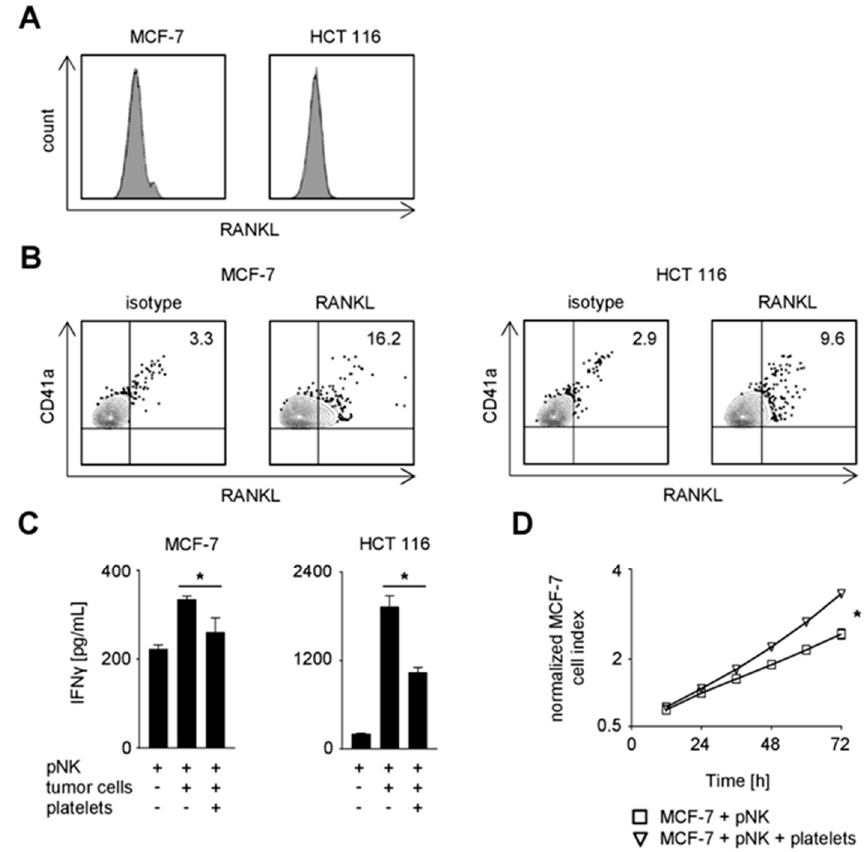
Figure 4. Cont Figure 4. Cont.